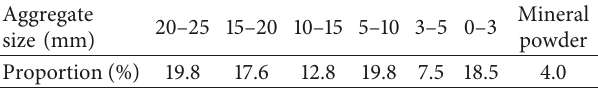
Table 4: Aggregate composition of asphalt